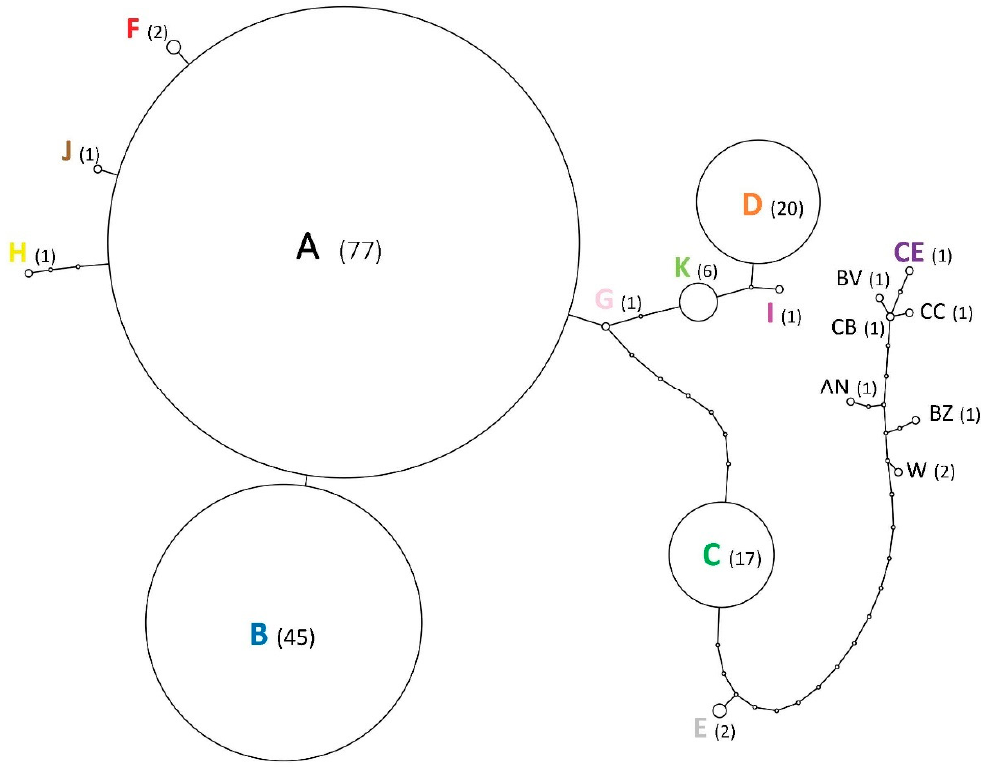
Figure 2. Minimum-spanning network of Reticulitermes flavipes mtDNA haplotypes. The haplotypes are color coded, and sample size is indicated in parentheses.